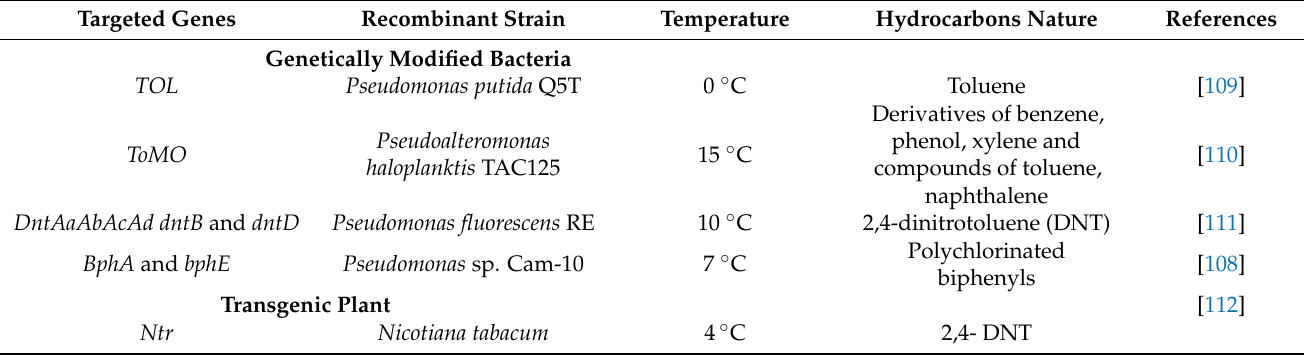
Table 6. Potential cold-adapted recombinant strain in hydrocarbon bioremediation